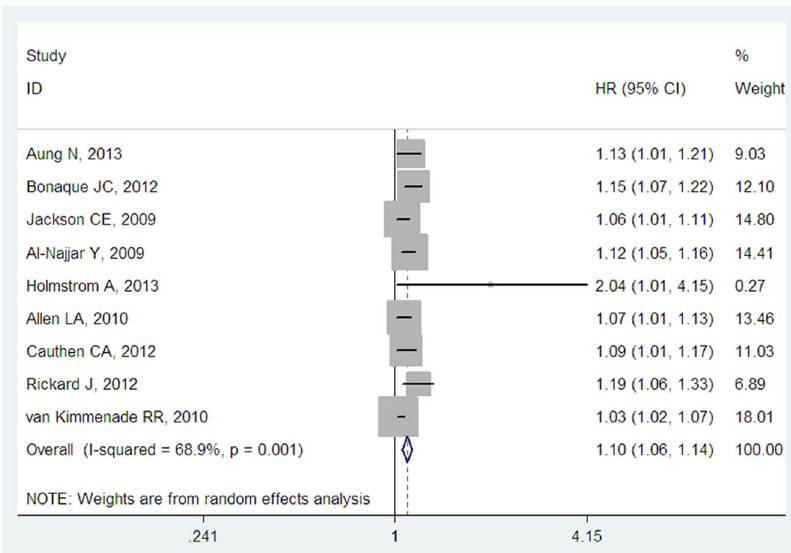
Figure 2. Forest plot of the HR for each 1% increase in RDW for ACM in HF patients. Each solid rectangle represents an eligible study. The size of each solid rectangle reflects the sample size of the eligible study. Error bars represent 95% confidence intervals (CIs). RDW, red blood cell distribution width; HF, heart failure.